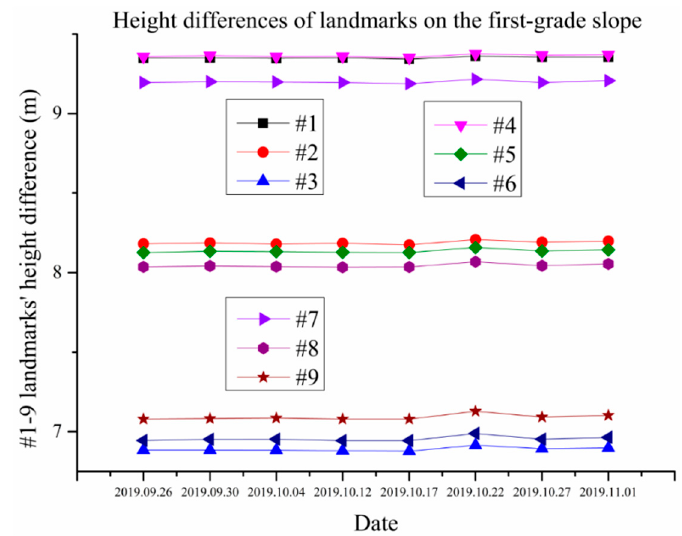
Figure 16. Height difference change charts of landmarks on the first-grade slope.